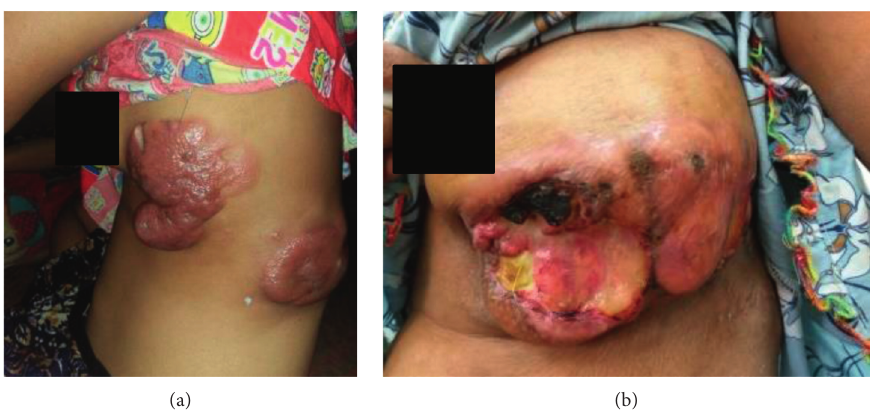
Figure 1: (a). Cutaneous manifestations at 2015: skin nodules on the left lower chest and loin region. (b) One of the cutaneous man- ifestations at the time of admission: large ulcer with some necrotic tissue (11 × 6cm in size) at left lower chest